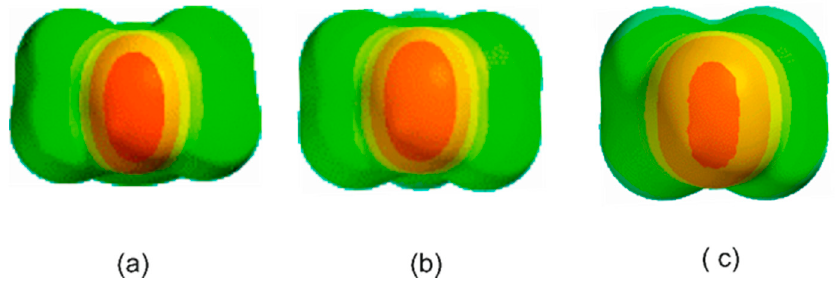
Figure 7. Molecular electrostatic potential at the 0.001 e bohr − 3 isodensity surfaces of ( a ) 2,5- dihydrofuran, ( b ) oxetane and ( c ) oxirane.